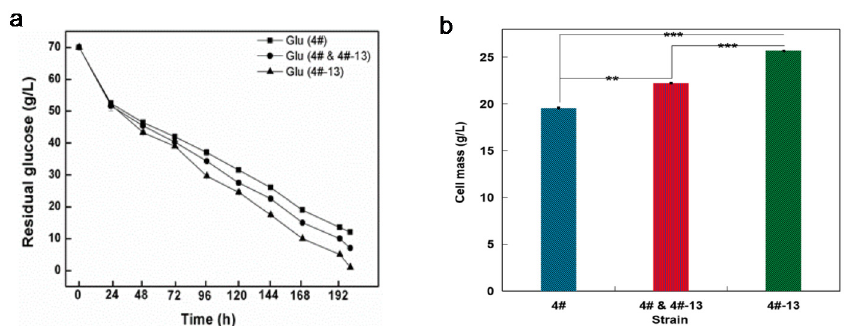
Figure 4. Lipid production with 100 mL cell culture in 250 mL shaking flasks by R. toruloides strains. ( a ) Evolution of residual glucose. ( b ) Cell mass of cultures with different strains. The experiments were done in three technical replicates. Statistical significance (** p < 0.01;***, p < 0.001) was determined by one ‐ tailed Students, t ‐ test. Data are means ±SD of three replicates.